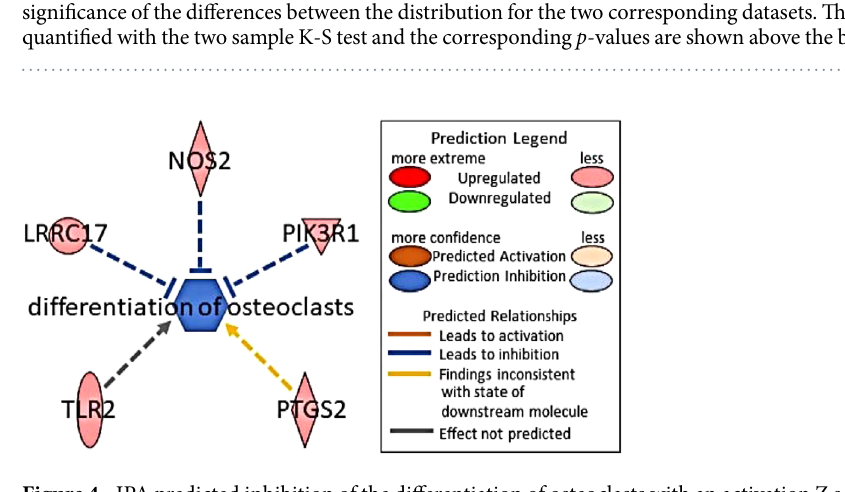
Figure 4. IPA predicted inhibition of the differentiation of osteoclasts with an activation Z score of − 1.07 with a p -value <